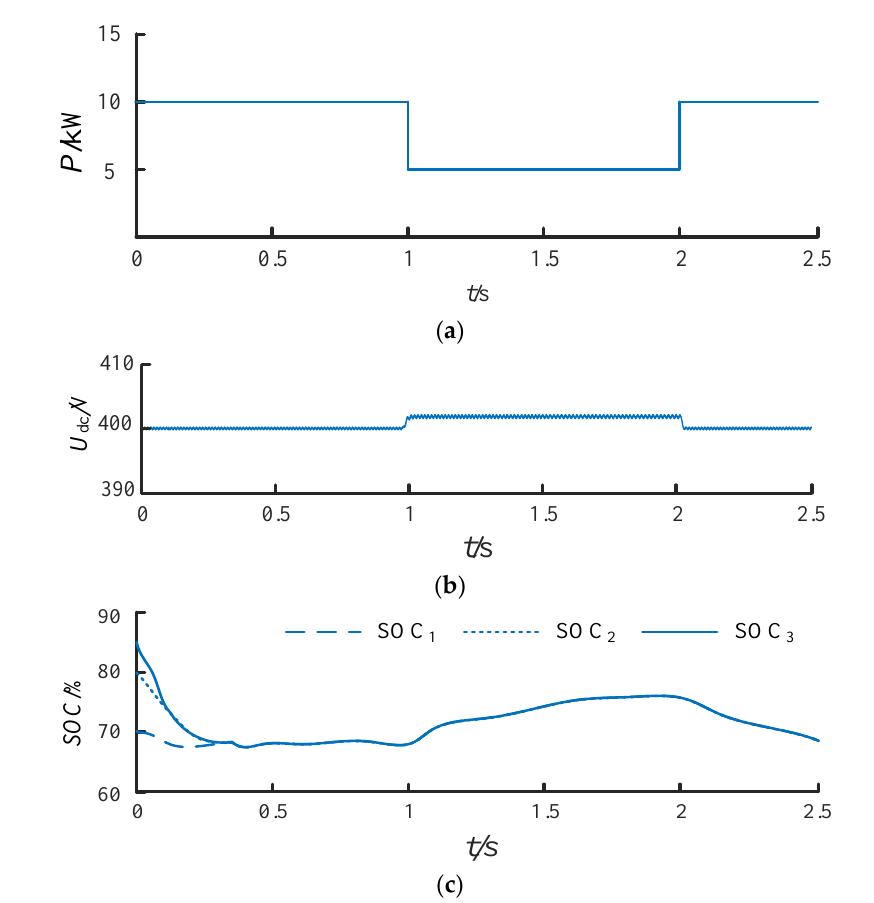
Figure 13. System simulation under sudden load change. ( a ) Load power. ( b ) Bus voltage. ( c ) ESU output power.